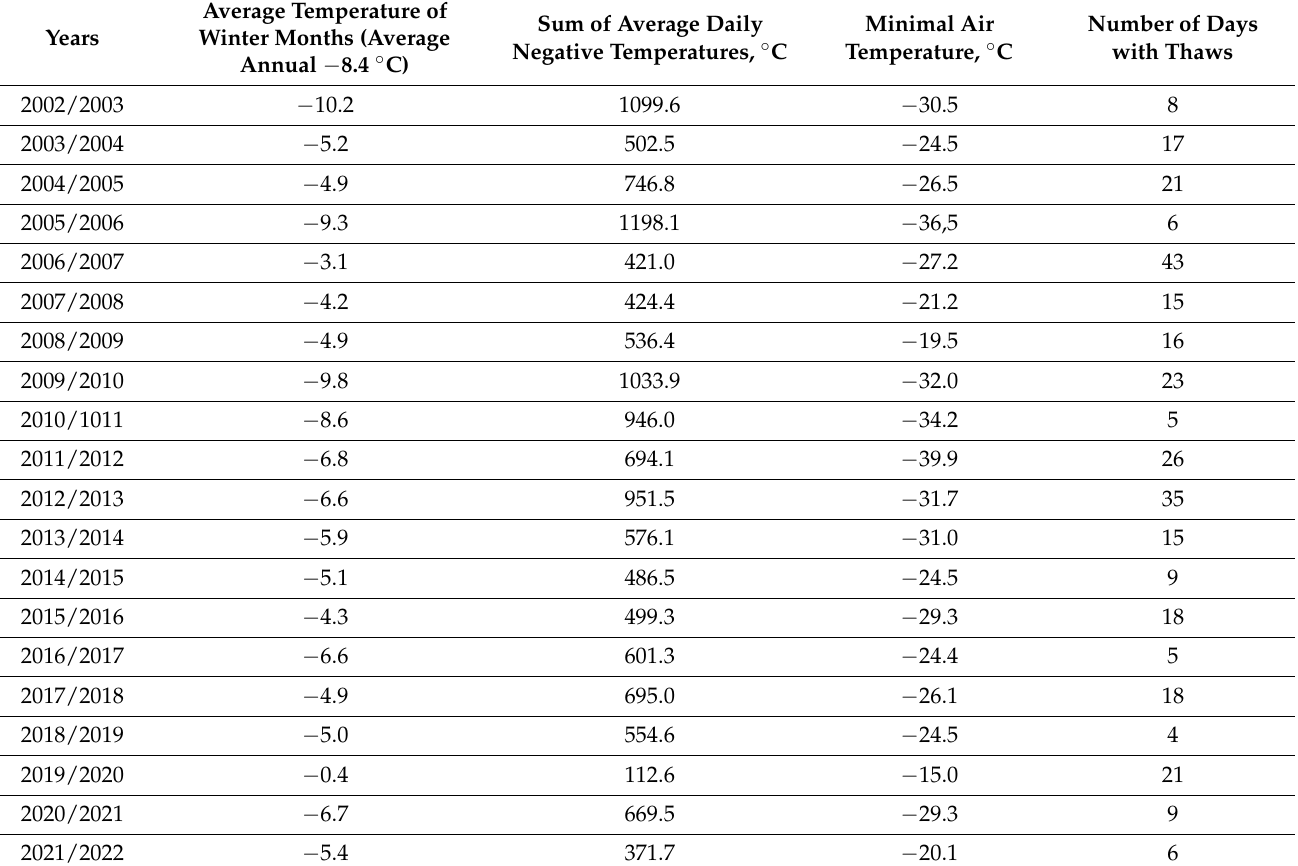
Table 3. Winter conditions in 2002–2022 (data of VNIISPK weather